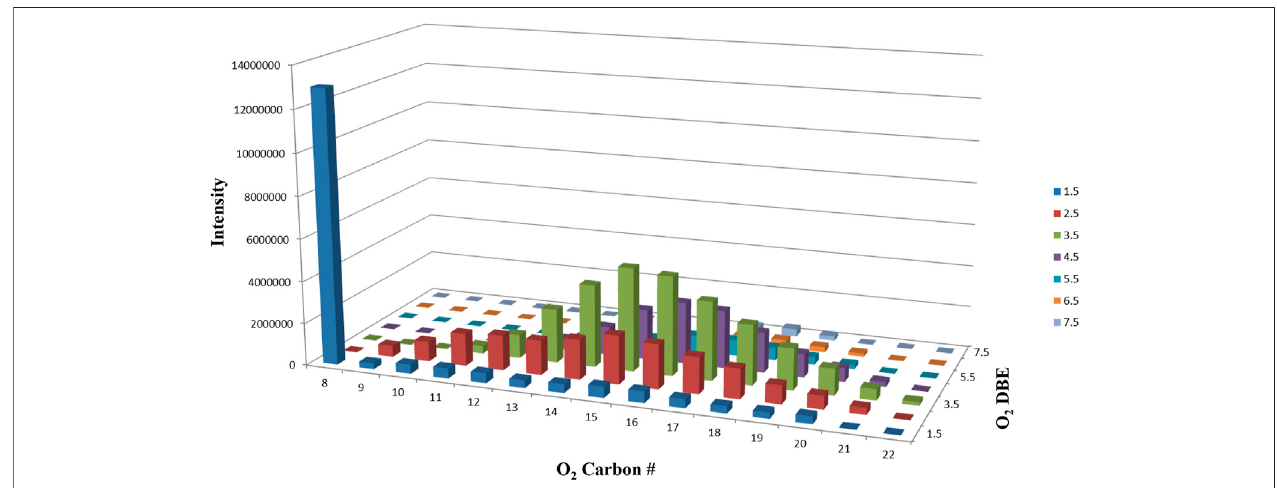
FIGURE 1 | Structural distribution of O 2 naphthenate species arranged by total carbon number and double bond equivalents (DBE) in a standard sodium naphthenate sample used in Hexagenia spp. toxicity